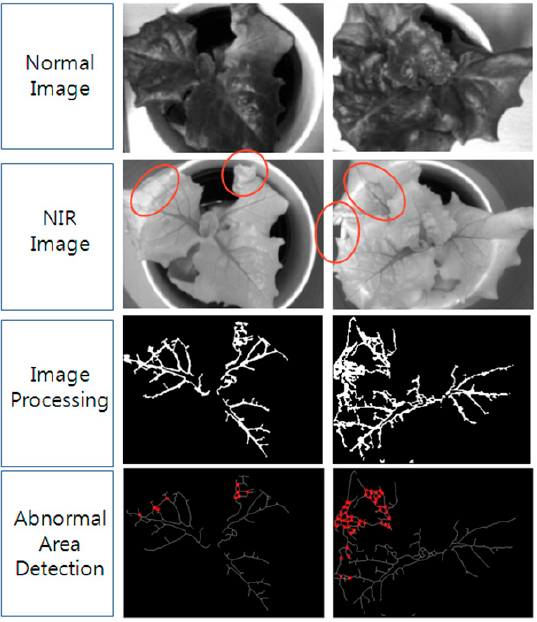
Figure 11. The image in the anomaly detection process using NIR images.